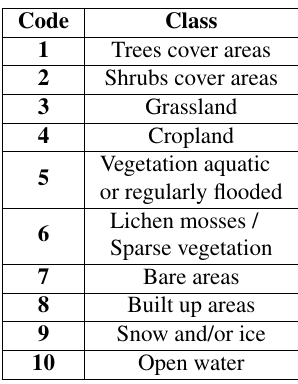
Table 3. Link between the classes of CCI Africa Prototype and